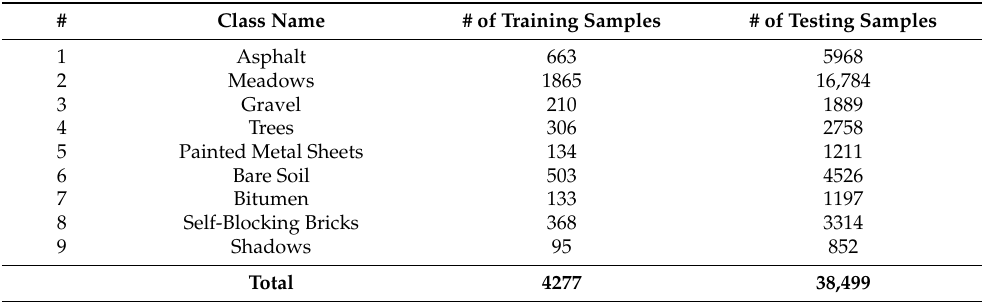
Table 3. Total number of class-specific training and testing samples used for University of Pavia University dataset with 10% of training data.